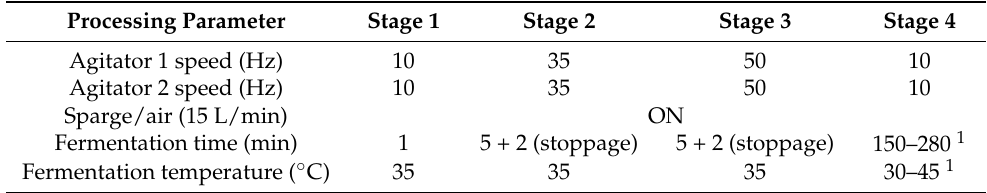
Table 1. Ferment processing conditions (standard four-stage fermentation cycle).